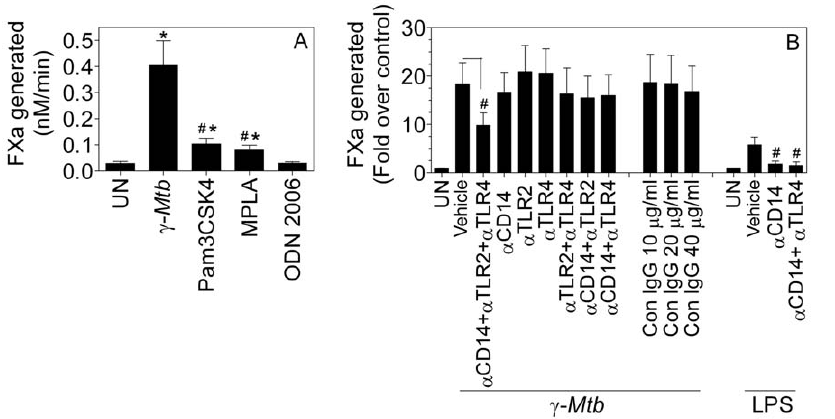
Figure 5. TLR2 and TLR4 along with CD14 receptor are partly responsible for c -Mtb -mediated TF induction. ( A ) MDMs were treated with TLR2 agonist (Pam3CSK4, 1 m g/ml), TLR4 agonist (MPLA, 1 m g/ml) and TLR9 agonist (ODN2006, 10 m g/ml) for 9 h. As a control, MDMs were also treated with c - Mtb H37Rv (10 m g/ml). Cell surface TF activity was determined in factor X activation assay.* indicates significant difference compared to untreated cells (P # 0.01); # denotes significant difference compared to c - Mtb treated cells (P , 0.01) ( B ) MDMs were preincubated with CD14, TLR2 and TLR4 blocking antibodies (each, 10 m g/ml) either alone or in combination and with isotype control IgG for 45 min at 37 u C and then cells were stimulated with c - Mtb for 9 h. At the end of the stimulation period cell surface TF activity was measured in factor X activation assay. # denotes significant inhibition compared to c - Mtb or LPS alone treated cells (P , 0.05); paired t-test. Data are mean 6 SEM (n=3–8).